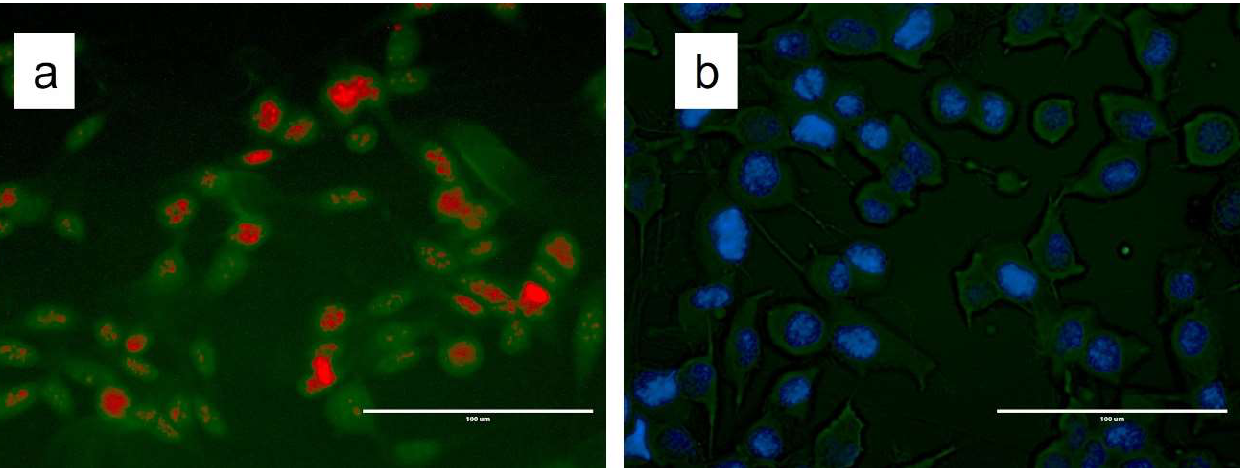
Figure 6. Fluorescence microscopy showing CL interacting with the cellular membrane. Fluorescent CL liposomal formulation encapsulated with DNR ( a ) or no DNR ( b ). Red represents DNR while green represents fluorescent CL. Blue represents nuclei of cells stained with DAPI while green represents fluorescent CL.